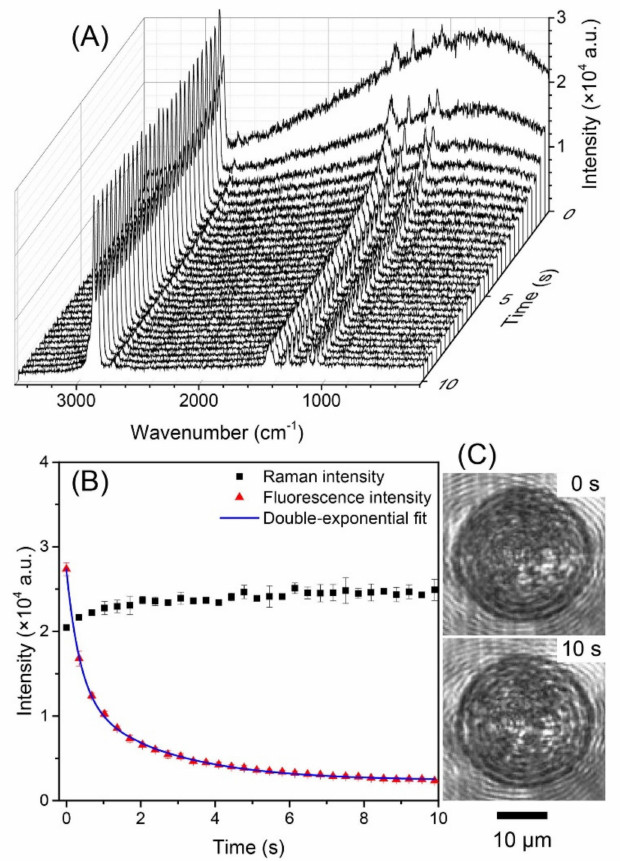
Figure 9. The evolution process from fluorescence to Raman spectra of a single strongly absorbing rhodamine-B-doped PE microsphere in the optical trap. ( A ) The time-resolved spectra in the first 10 s. ( B ) The fluorescence intensity (red triangles) was fitted to a double-exponential decay (blue solid line). The intensity of the Raman peak at ~2890 cm − 1 (black squares) remained relatively constant. ( C ) Images of the trapped particle taken at 0 s and 10 s. (Reprinted with permission from [181]. Copyright (2107)